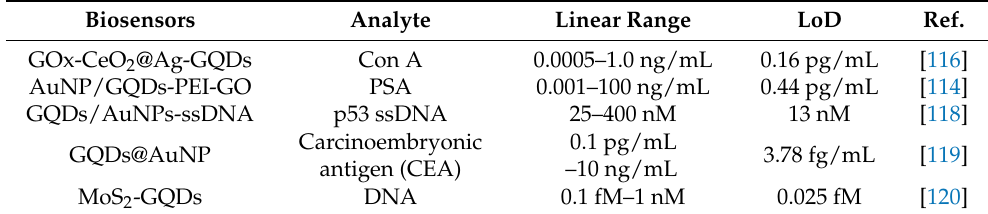
Figure 12. GQD nanocomposites as SERS-based biosensors. ( a ) SERS signal from different concen- trations of CFP-10 antigen on Fe 3 O 4 -Au-GQDs nanocomposites and ( b ) the corresponding linear correlation between the logarithmic CFP-10 antigen concentrations versus Raman peak intensities at 1579 cm − 1 [117]. ( c ) Schematic illustration of SERS imaging on cellular surface glycans and ( d ) the corresponding SERS mapping images of single L02, HeLa, and MCF-7 cell based on the intensity of 1333 cm − 1 [85]. ( e ) Schematic illustration of the SERS activity of Ag/o-GQDs nanocomposites for in situ catalytic oxidation of TMB for monitoring H 2 O 2 in cancer cell [84]. Table 4. Summary of the GQD nanocomposites for ECL-based biosensing